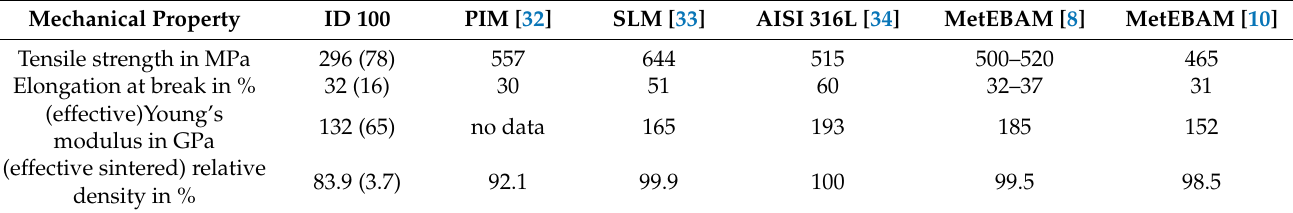
Table 4. Comparison of metEBAM produced 316L stainless steel with PIM and SLM material properties. It is to note that the median values of ID 100 were taken from the tensile specimens, additionally, the standard deviation is given in brackets.